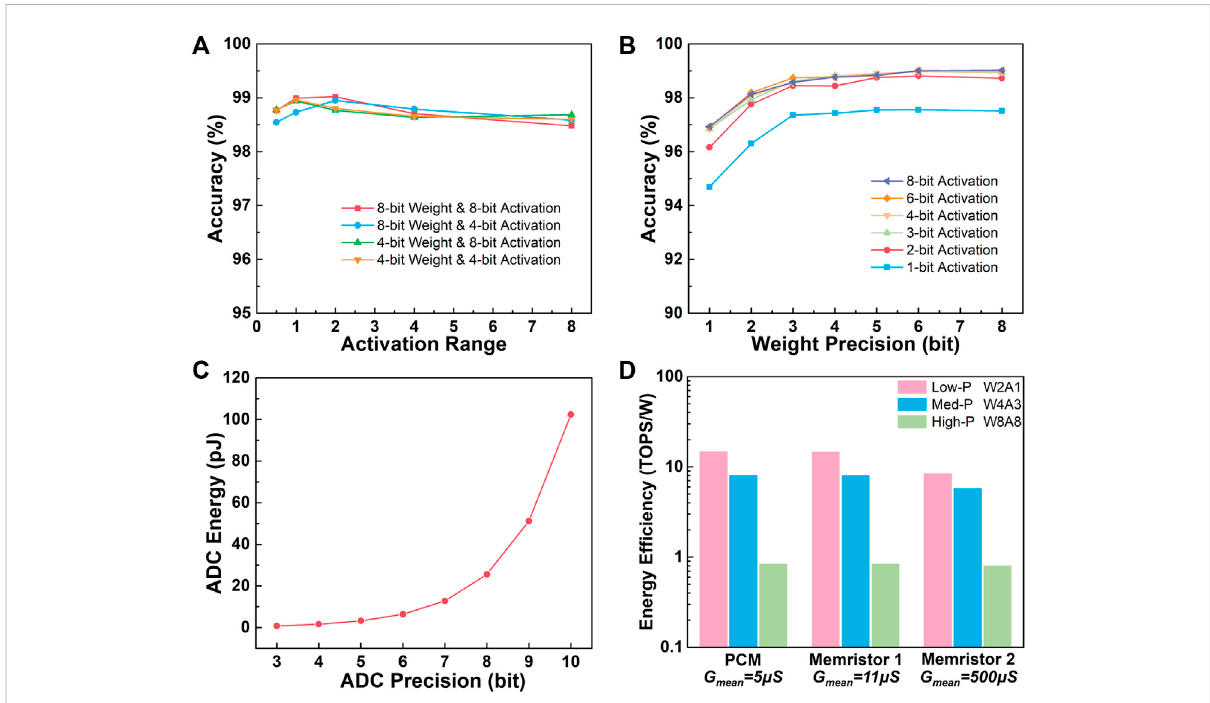
FIGURE 2 (A) The effect of clipped activation range on the network accuracy of the MNIST dataset according to different quantization conditions. (B) The effects of weight and activation quantization on the network accuracy of the MNIST dataset. Especially, the 1-bit weight precision denotes the binary-weight case. (C) The energy consumption of the leading ADCs with respect to their precisions. (D) Evaluation of the overall energy ef fi ciency of the MAC units with 128 × 128 device array according to different quantization precision